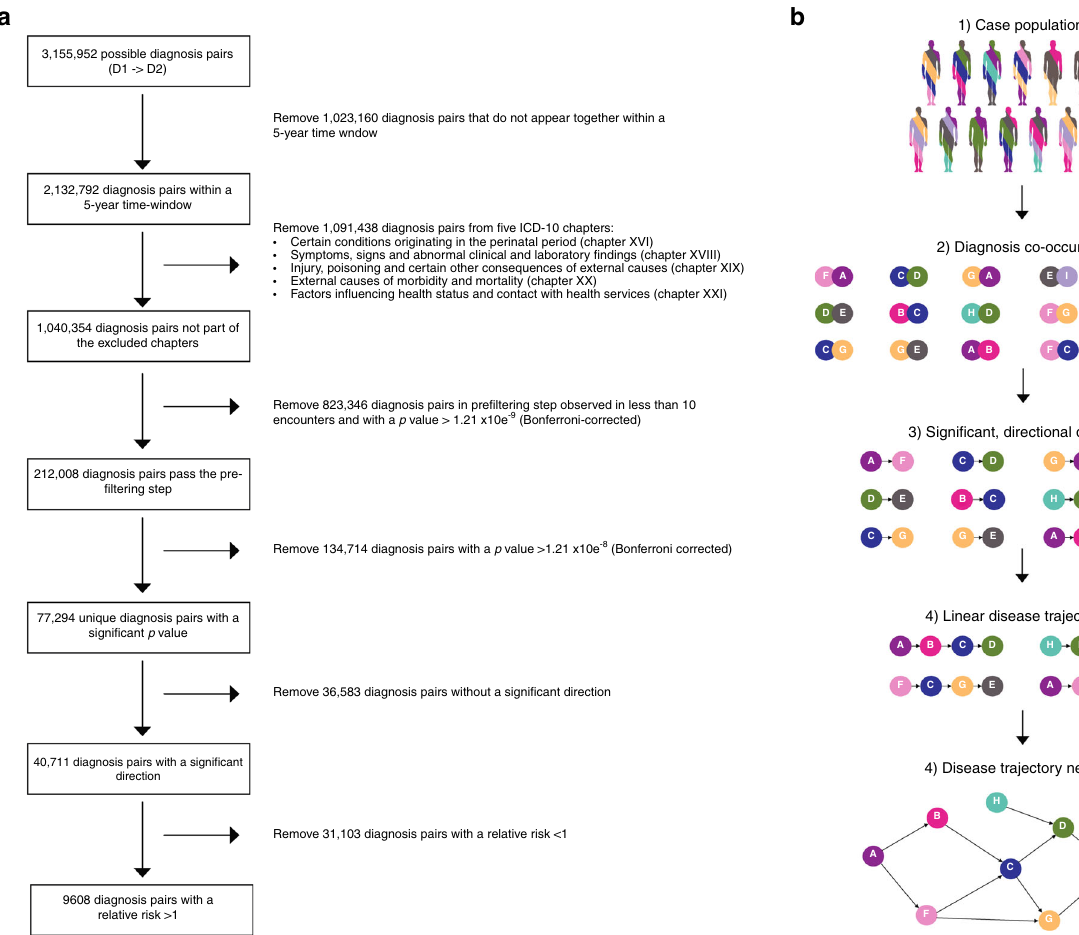
Fig. 1 Register data processing. Disease trajectory algorithm fl owchart ( a ) and schematic representation of the disease trajectory algorithm that is the foundation for Danish Disease Trajectory Browser functionality ( b ). a Pre- fi ltering and computation of statistically signi fi cant diagnosis pairs in The Danish National Patient Registry (NPR), containing data on 7,186,865 patients. b (1) Users select a ICD-10 indexed patient population by typing ICD-10 code(s) or disease(s) of interest (ICD-10 code, level 3). (2/3) The fi rst step where the algorithm identi fi es statistically signi fi cant directional diagnosis pairs. (4/5) The second step where the algorithm builds linear trajectories by concatenating statistically signi fi cant diagnosis pairs, that can then be merged into a disease trajectory network, consequent to the fact that one disease may appear in more than one linear disease trajectory. ICD-10 International Classi fi cation of Diseases, 10th Revision. Colours indicate disease category. Table 1 The Danish Disease Trajectory Browser data foundation and examples. The Danish National Patient Registry Years of